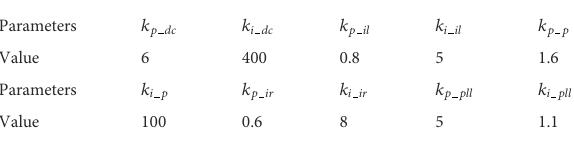
TABLE 2 DFIG control parameters. TABLE 3 Wind speed of each unit in DFIG-based wind farm